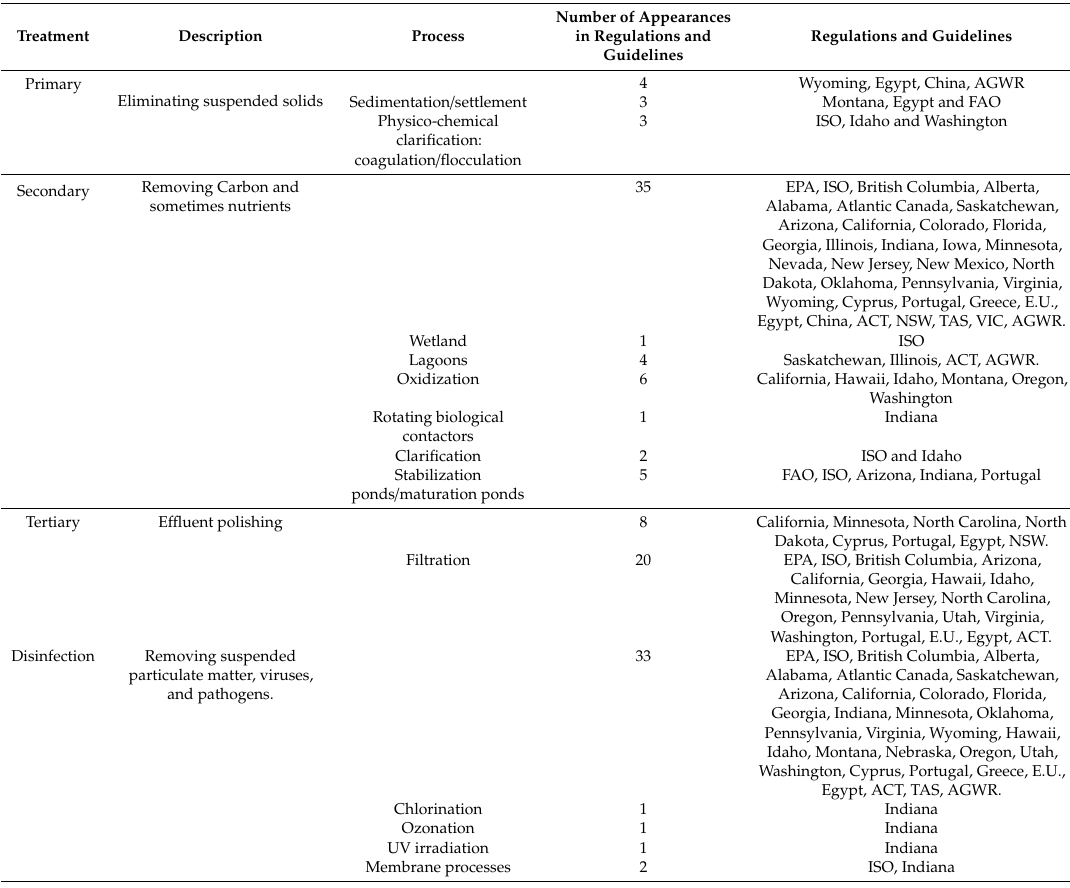
Table 21. The number of regulations and guidelines which indicated di ff erent